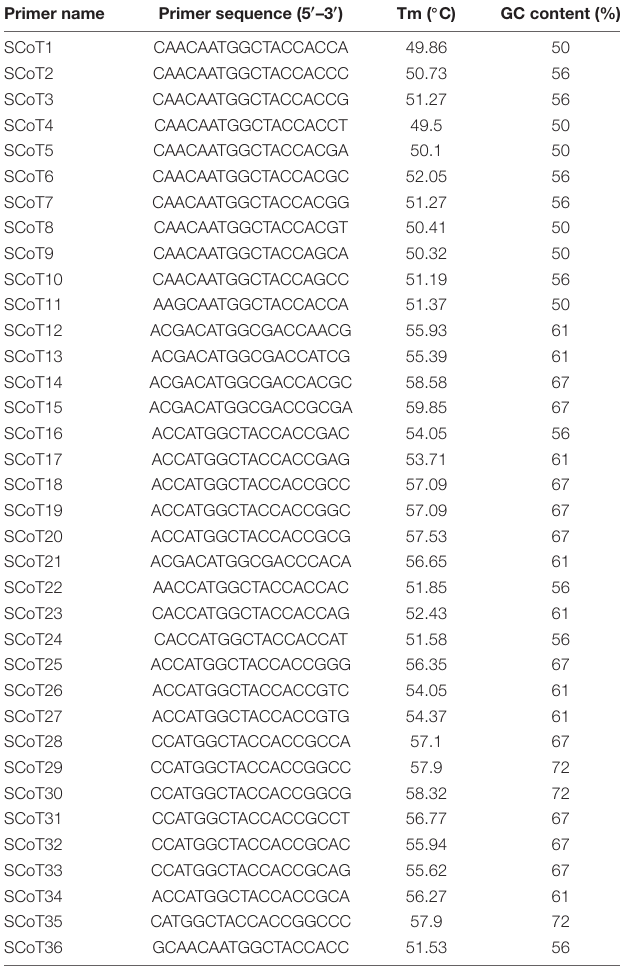
TABLE 2 | List of Dendrobium officinale populations used for SCAR markers